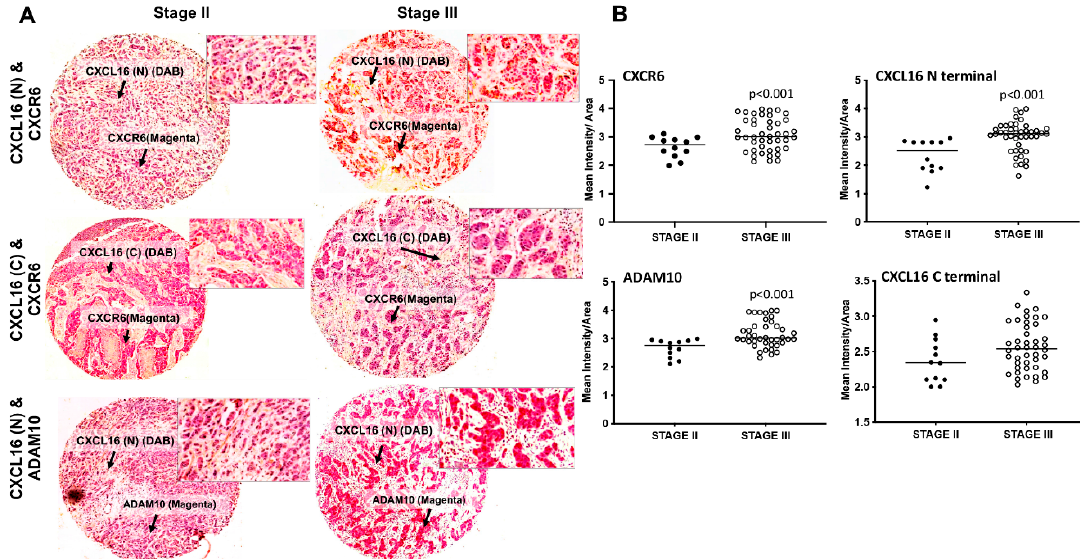
Figure 1. Expression of ADAM10, CXCR6, and CXCL16 in breast cancer tissues. Tissue microarrays consisting of stage-II ( n = 12) and stage-III ( n = 63) BrCa tissues were analyzed by immunohistochemistry. Representative images of tissue sections along with TMA spots are shown in Panel ( A ). Brown (DAB) color shows CXCL16 staining, and magenta shows CXCR6 or ADAM10 expression. Quantitation of immunohistochemistry is shown in Panel ( B ). Expression of CXCR6, N-terminal CXCL16, and ADAM 10 was higher in stage-III than stage-II BrCa tissues. There was no significant difference in the levels of C-terminal CXCL16 in BrCa tissues of different stages. The statistical significance for differences in expression between groups was analyzed using the Mann–Whitney U test.